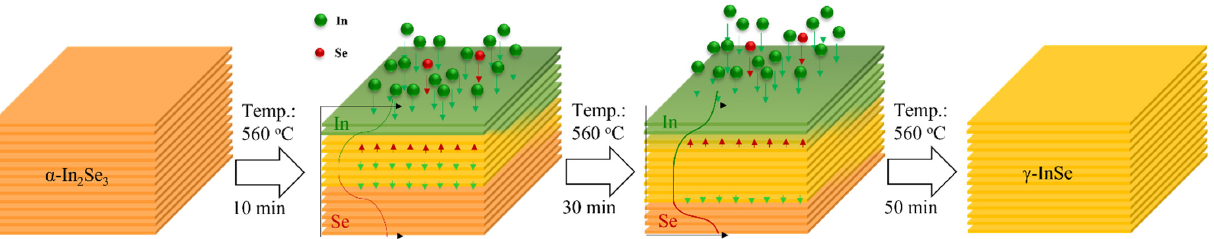
Figure 5. Schematic illustration showing growth mechanism of single-phase γ -InSe film via solid- phase epitaxy.